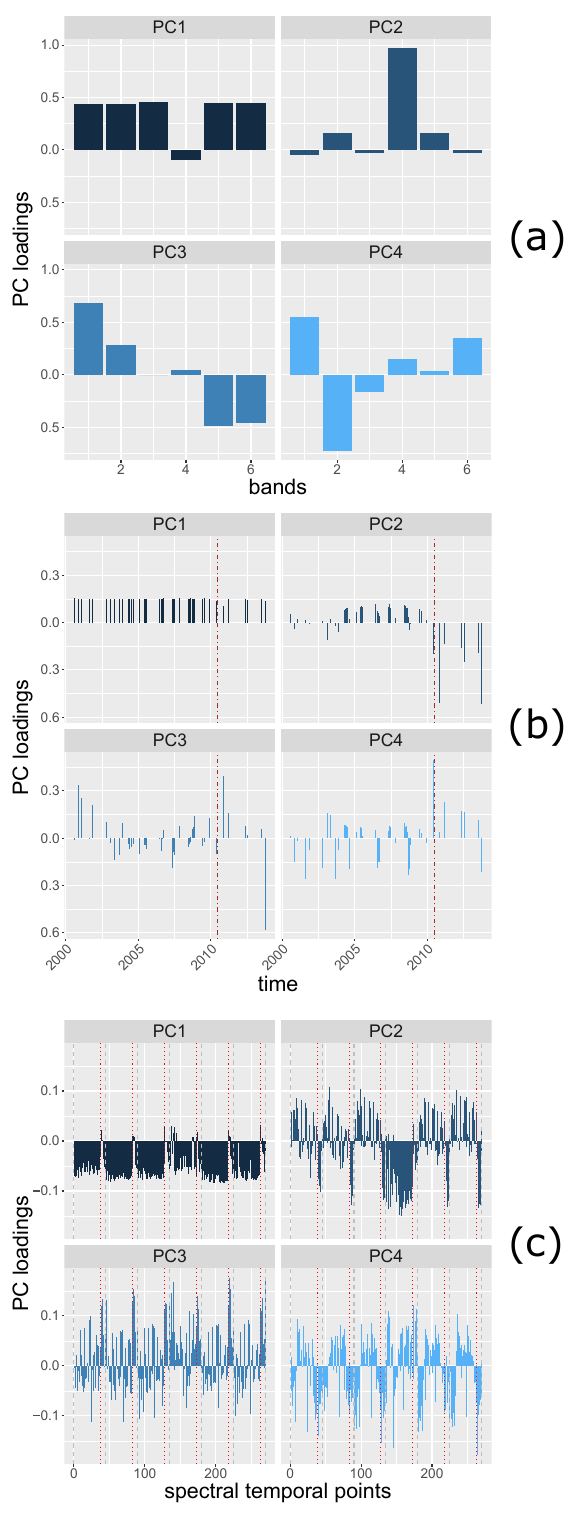
Figure 6. PC loadings (1–4) of Mb ( a ), Mt ( b ) and Mbt ( c ). The brown vertical line indicates the time of the harvesting event. The points between two grey vertical lines are spatial points of a spectral